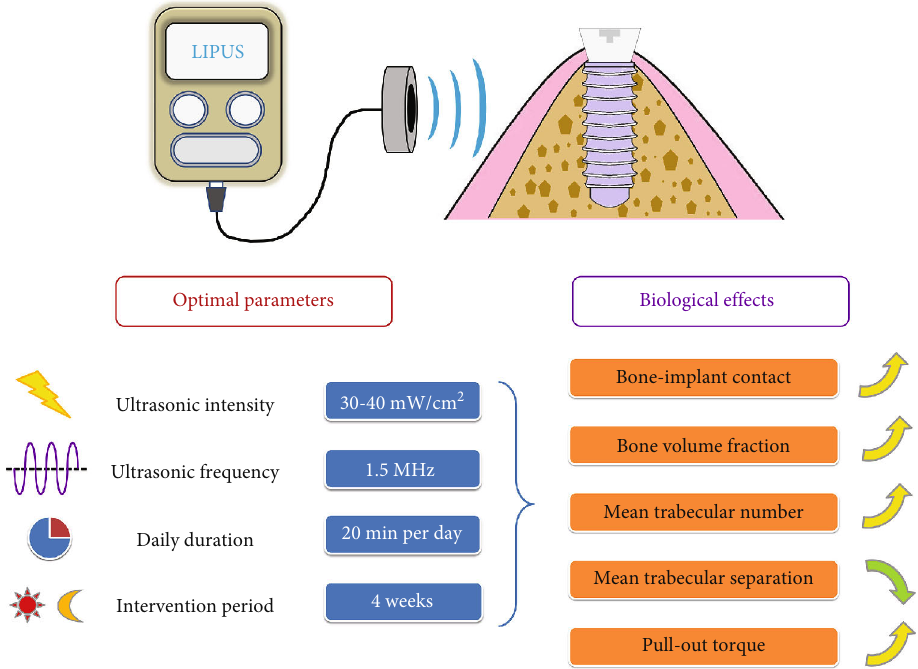
Figure 2: Schematic diagram of the optimal parameters and biological e ff ects of LIPUS used in dental implantations. Based on the results of previous studies, LIPUS intervention at 30 – 40 mW/cm 2 intensity and 1.5MHz frequency for 20min/day for 4 weeks is the most commonly used and e ff ective scheme for promoting dental implant